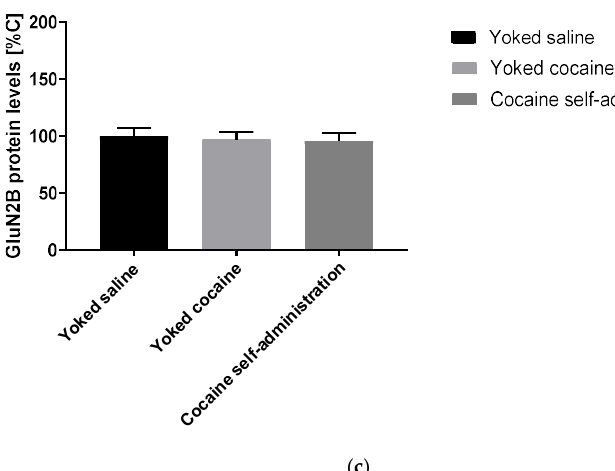
Figure 3. Changes in the expression of NMDA receptor subunits (GluN1, GluN2A and GluN2B) in the nucleus accumbens in rats following cocaine self-administration. All data are expressed as % of control (mean ± SEM). N = 6 rats/group. * p < 0.05 vs. yoked saline. ( a ), GluN1 protein levels [% of control]; ( b ), GluN2A protein levels [% of control].; ( c ), GluN2B protein levels [% of control].